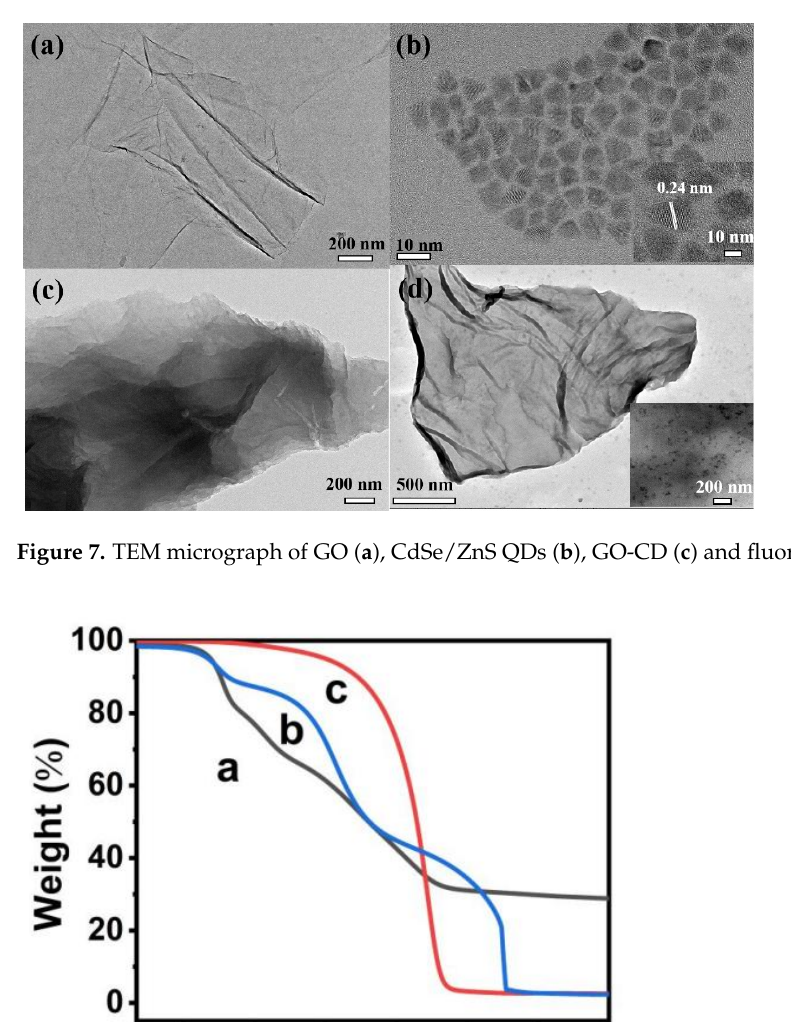
Figure 6. Raman spectra of GO (a) and QDs/polymer/GO fluorescence nanohybrid (b).